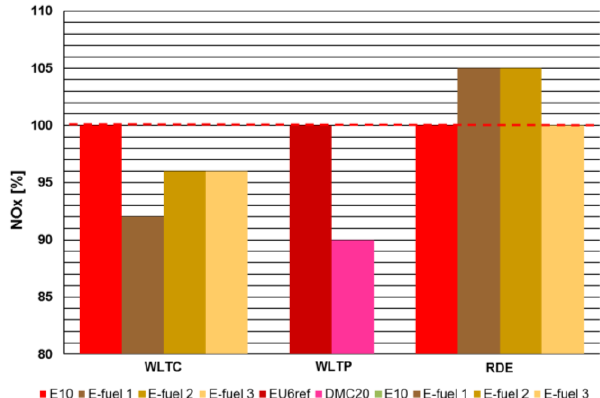
Fig. 1. Changes in the mean NO x exhaust emissions for various synthetic fuels compared to conventional petroleum fuels as measured in the WLTC, WLTP and RDE tests [14,